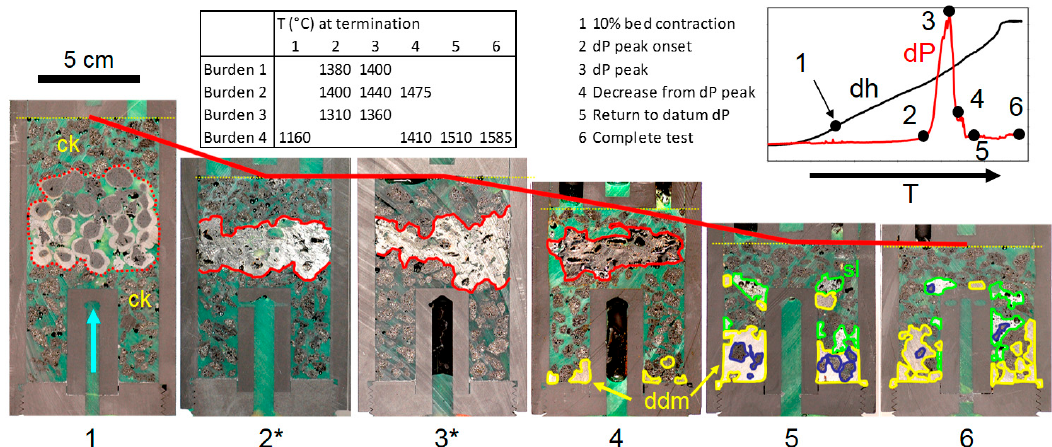
Figure 3. Appearance of vertically (longitudinally) sectioned post-experimental samples stopped at points 1–6 as illustrated. Samples for 1, 4–6 using burden 4 (M4), samples for 2* and 3* using burden 3 (M3). Red outlines highlight ferrous burden layer. ck = coke; ddm = dripped-down metal; sl = slag. Blue arrow indicates gas inlet extending from bottom of crucible.